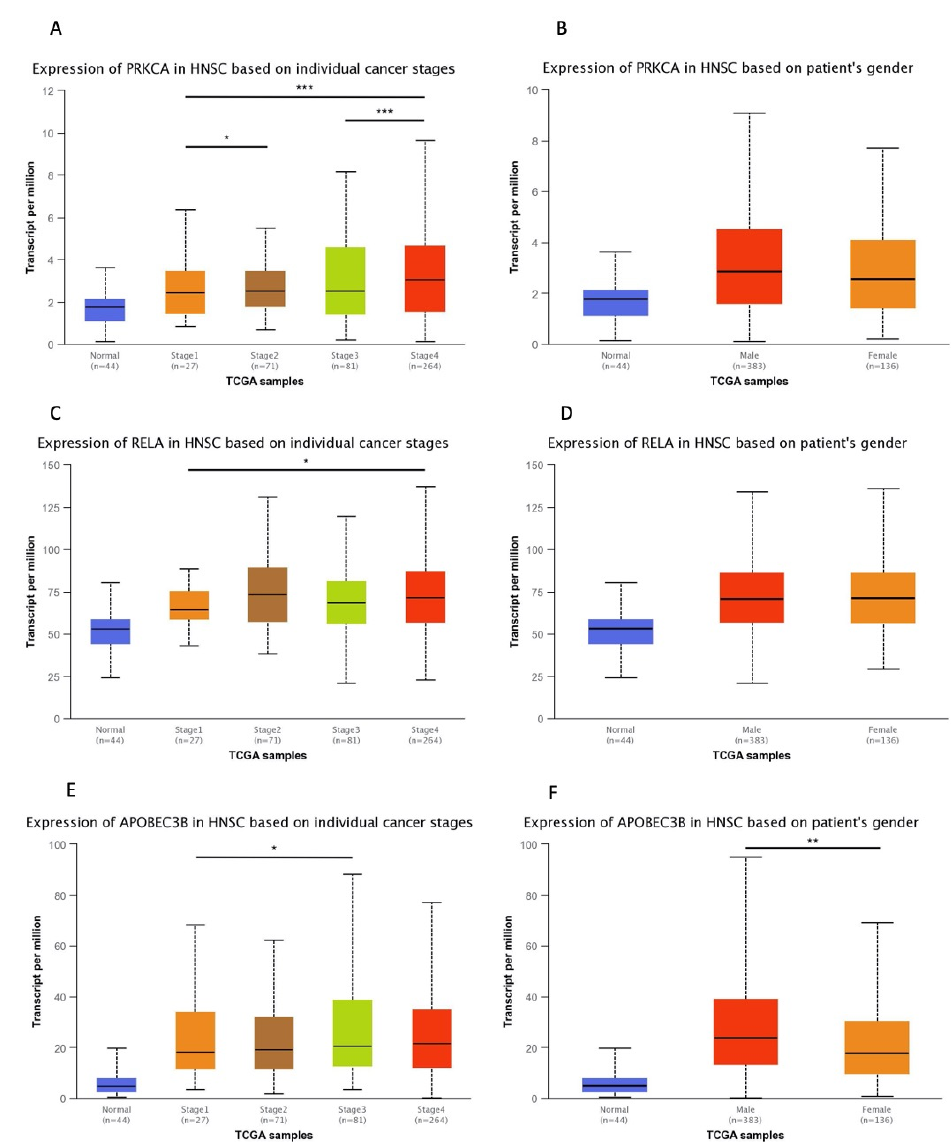
Figure 3. Differential expression analysis of APOBEC3B , PRKCA and RELA mRNA in HNSCC subgroups based on the UALCAN database. mRNA expression of PRKCA in HNSCC subgroups based on: ( A ) individual cancer stages; and ( B ) sex. mRNA expression of RELA in HNSCC subgroups based on: ( C ) individual cancer stages; and ( D ) sex. mRNA expression of APOBEC3B in HNSCC subgroups based on: ( E ) individual cancer stages; and ( F ) sex. (* p < 0.05, ** p < 0.01, *** p < 0.001). Table 2. PKCa, NF- κΒ and APOBEC3B protein expression in oral and oropharyngeal squamous cell carcinomas.